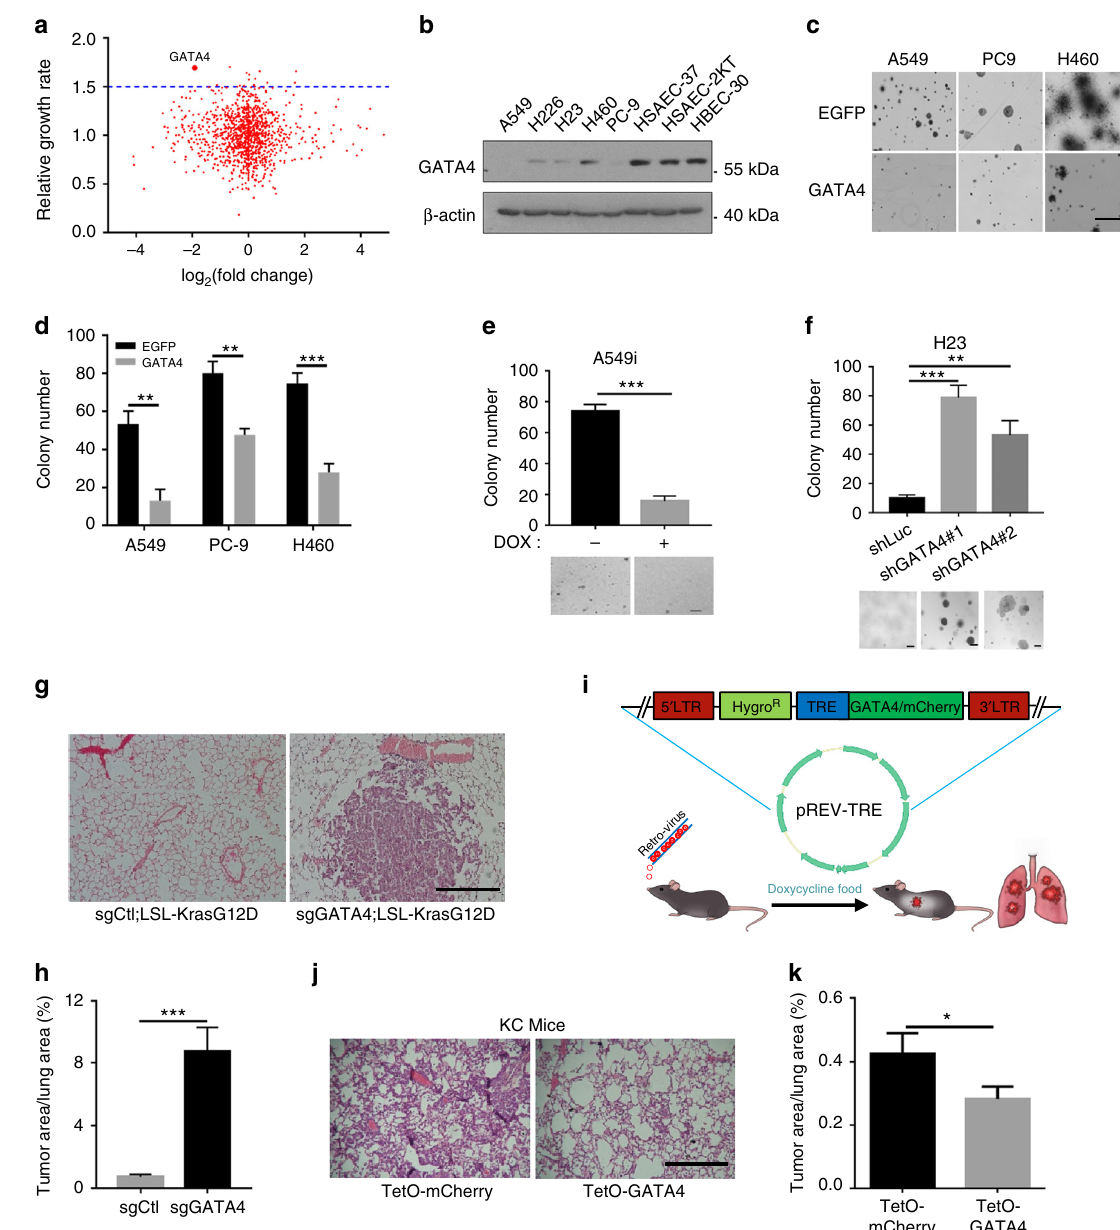
Fig. 1 GATA4 is an important tumor suppressor in lung cancer. a Scatterplot of relative growth rate against relative expression level. 10,000 H23 cells per well seeded in 96-well plate; siRNA transfected into individual wells. CCK8 value of a well 3 days post siRNA transfection was plotted against relative expression value of the corresponding gene in tumor (one replica). b Western blot analysis of GATA4 expression in cancerous and normal lung cell lines. c Lung cancer cells infected with lentivirus for ectopic expression of GATA4. Soft-agar colony forming ability was compared between lung cancer cell lines (A549, PC-9, and H460) ectopically expressing GATA4 and EGFP. Scale = 500 μ m. d Statistics of soft-agar colony result shown in c ( n = 3 per group). e Colony number of 10,000 A549i cells in the absence or presence of Dox checked 14 days after seeding in soft agar plate. Upper panel: statistics of the soft-agar colonies. Lower panel: representative pictures of A549i cells treated with or without 2 μ g/mL of Dox ( n = 3 per group, scale = 100 μ m) (A549i is an engineered A549 clone harboring Dox inducible GATA4 expression gene element). f Soft-agar colony forming ability of stable H23 with GATA4 knockdown by shRNAs or control shRNA. Upper panel: statistics of soft-agar colony result of H23 knockdown with control or GATA4 targeting shRNAs. Lower panel: Representative pictures ( n = 3 per group, scale = 50 μ m). g Lsl-KRAS G12D infected with recombinant lentivirus coexpressing Cre and CRISPR/ CAS9 through nasal instillation. Lung tumor formation in KRAS G12D /GATA4-/- mice compared to KRAS G12D /TdTomato-/- mice 10 weeks post-infection. Scale = 200 μ m. h Statistics of percentage of tumor area in the lung represented in g (n = 3 per group). i Schematics of intranasal instillation of retrovirus for forced expressing GATA4 in Dox inducible Tet-KRAS G12C /CC10rtTA lung cancer mouse model (referred to as KC). j Pathology of lung tumor formation in KC mice infected with control (mCherry) or GATA4 expressing virus. Scale = 200 μ m. k Statistics of tumor area per lung area (n = 3 per group). Bars are represented as mean ± SEM of the indicated number ( n ) of repeats. *P < 0.05, **P < 0.01, and ***P < 0.001 by Student ’ s t